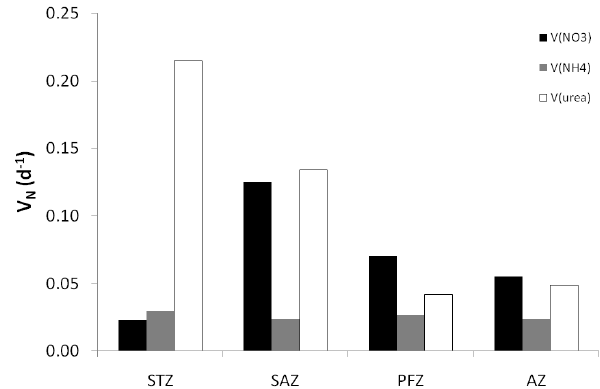
Fig. 5. Specific uptake ( V , d − 1 ) averaged over the euphotic zone Figure 5. Specific uptake (V, d -1 ) averaged over the euphotic zone for each region. It shows 846 the contribution V NO3 (black), V NH4 (grey) and V Urea (white) as % of total uptake, and a 847 for each region. It shows the contribution V NO decreasing trend V Urea from north to south. Latitudes for the different zones are STZ (34 – 848 (grey) and V Urea (white) as % of total uptake, and a decreasing trend 42.2 o S), SAZ (42.2 – 44.2 o S), PFZ (42.2 – 50.1 o S) and the AZ (50.1 – 57.5 o S). 849 V Urea from north to south. Latitudes for the different zones are